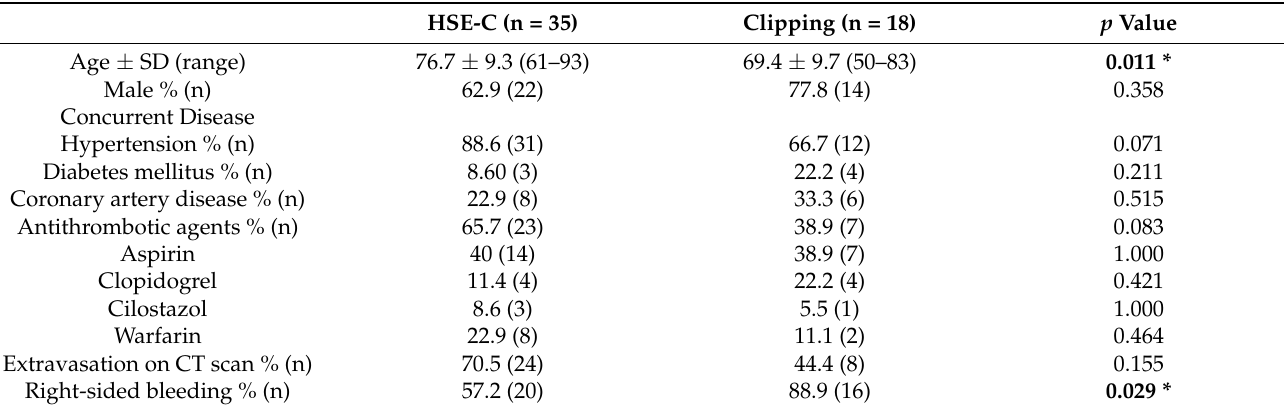
Table 1. Baseline characteristics and clinical findings of patients assigned HSE-C or clipping for active diverticular bleeding.